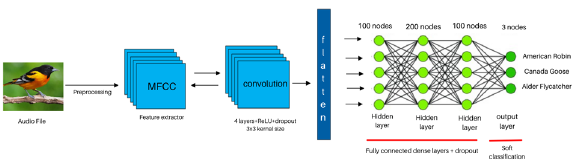
Figure 5: Bird audio detection using Convolutional Neural Network